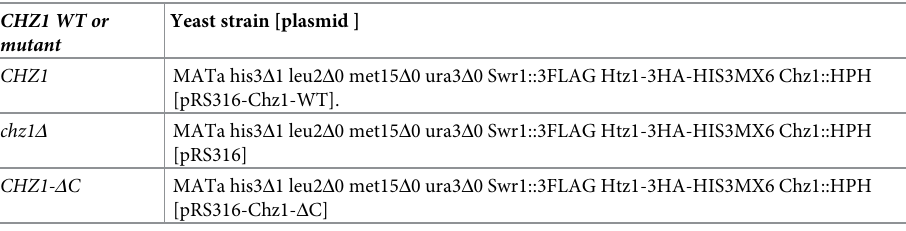
Table 4. Strains for ChIP-qPCR of the yeast cells used in this